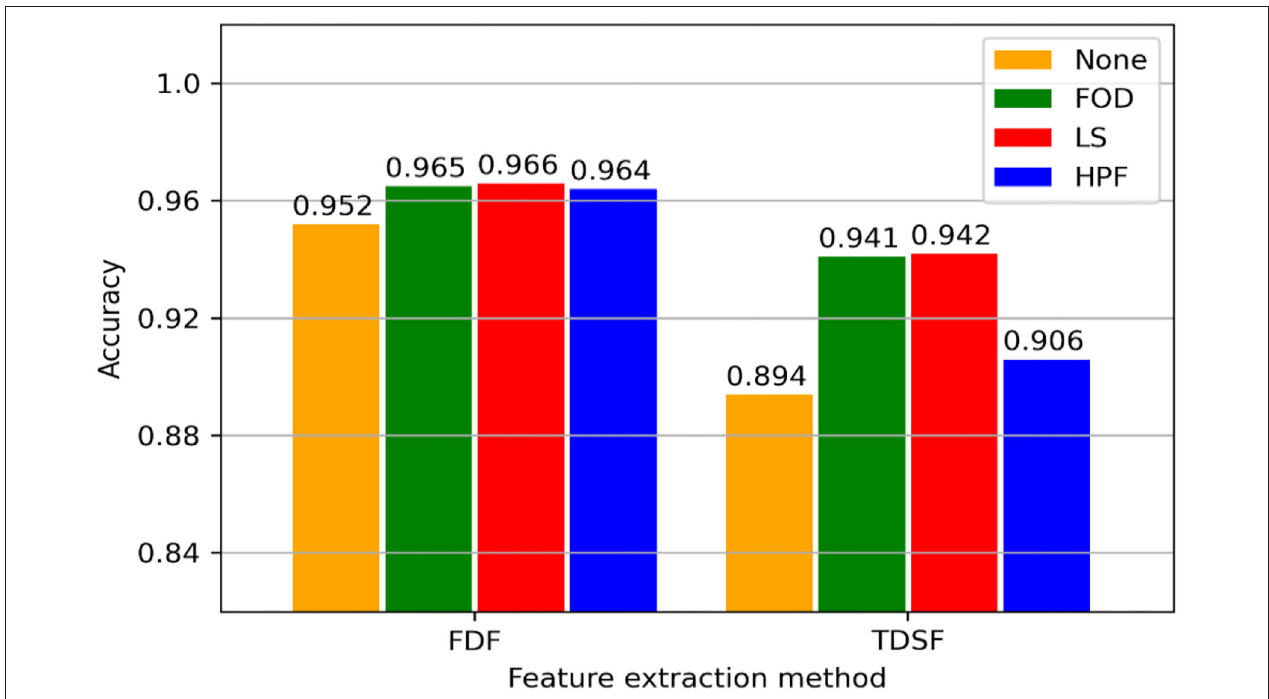
FIGURE 5 | Validation results for each model. “None” indicates the control group in data preprocessing without any data processing. FOD, First-order difference; LS, local slope; HPF, high-pass filter; FDF, frequency-domain features; and TDSF, time-domain statistical features.